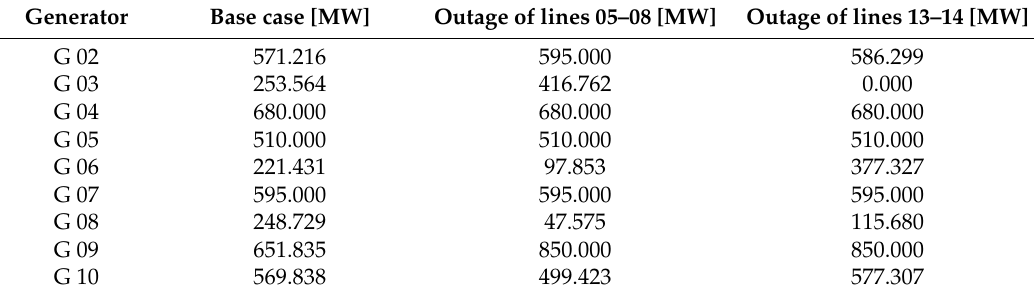
Table 3. Results of the economic re-dispatch after outage of lines 05-08 and